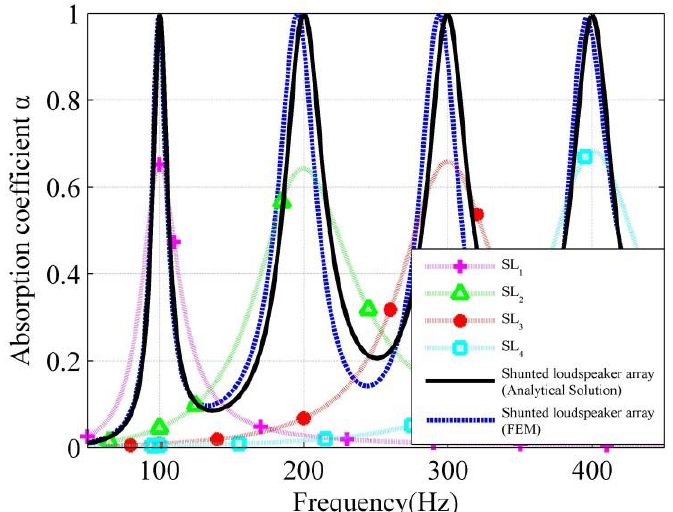
Figure 3. The normal incidence sound absorption coefficients by analytical solution and the finite element model method: SL 1 unit (magenta dotted line marked with plus sign), SL 2 unit (green dotted line marked with upward-pointing triangle), SL 3 unit (red dotted line marked with solid circle), SL 4 unit (cyanine dotted line marked with blank circle), shunted loudspeaker array by analytical solution (black solid line), shunted loudspeaker array by FEM (blue dashed line).